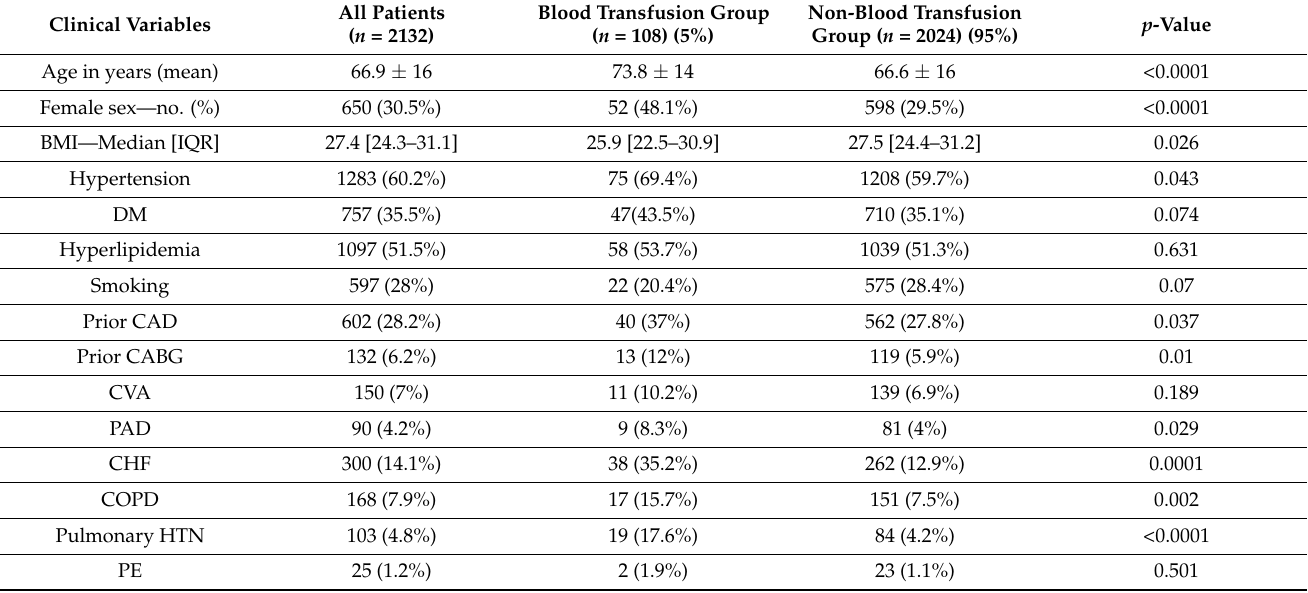
Figure 1. Number of BT units per patient during their admission. RBC = red blood cells. Table 1. Patients’ characteristics according to blood transfusion vs. non-blood transfusion.